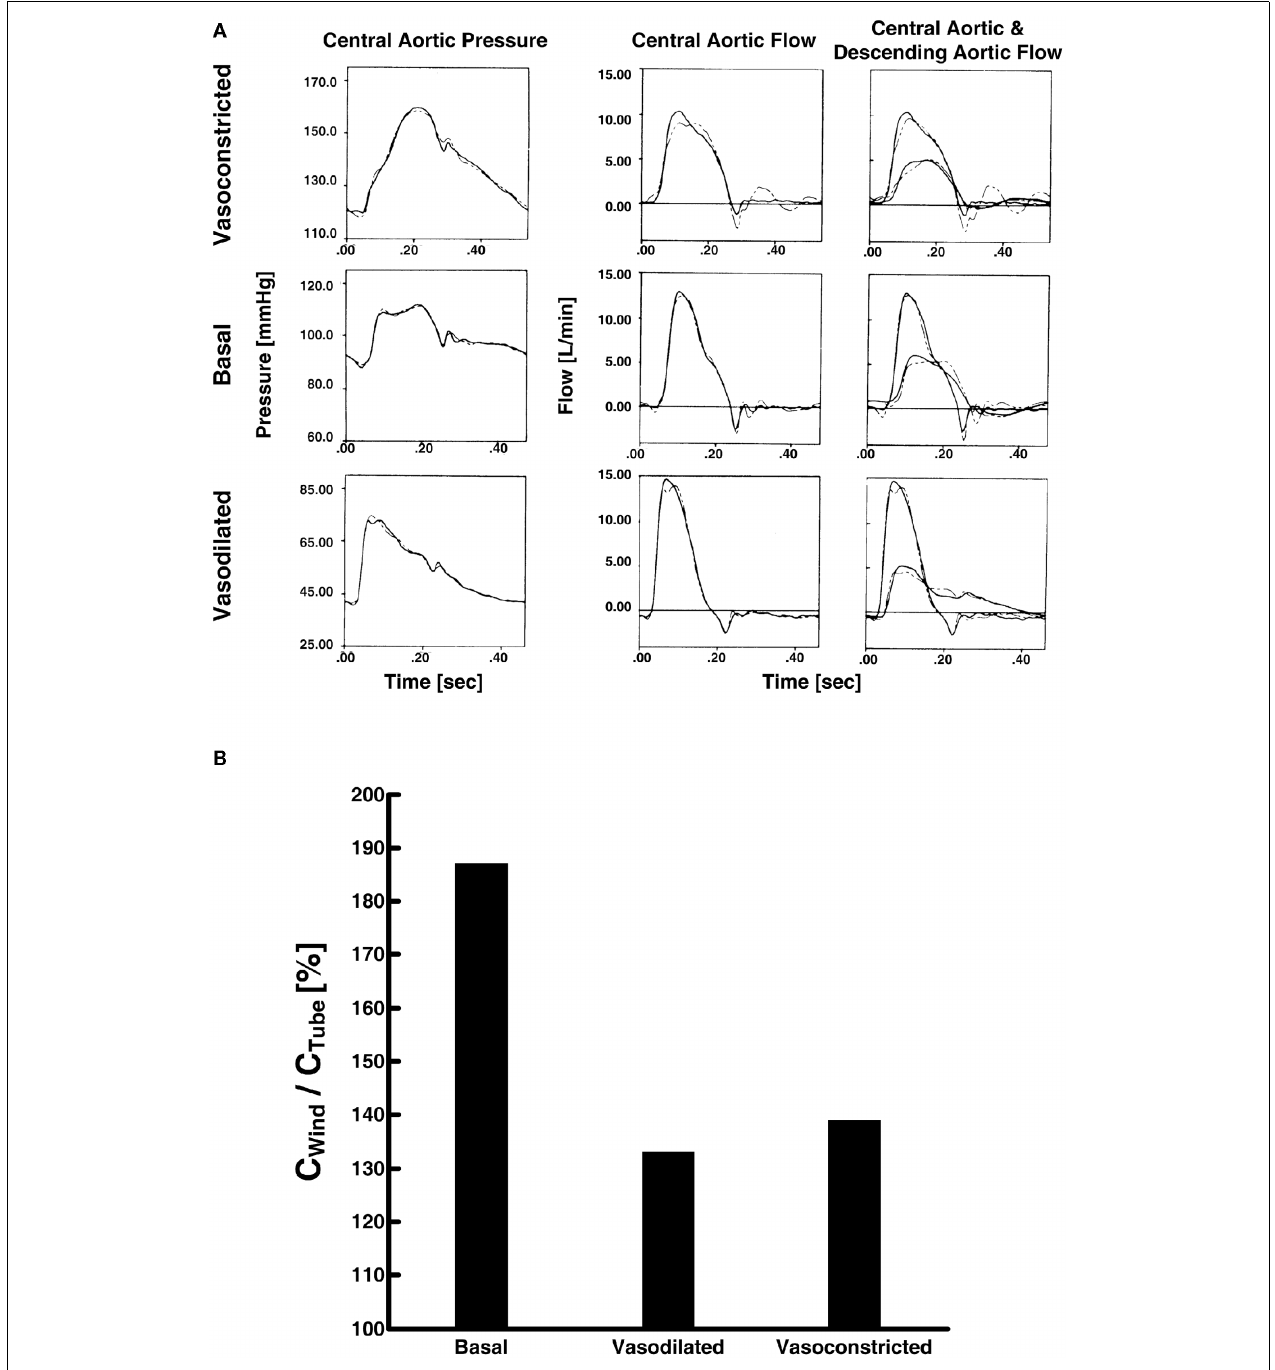
from Campbell et al. (1990). (B) Ratio of large artery compliance estimates viaWindkessel model (C Wind ) and tube-load model (C Tube ; Campbell et al.,